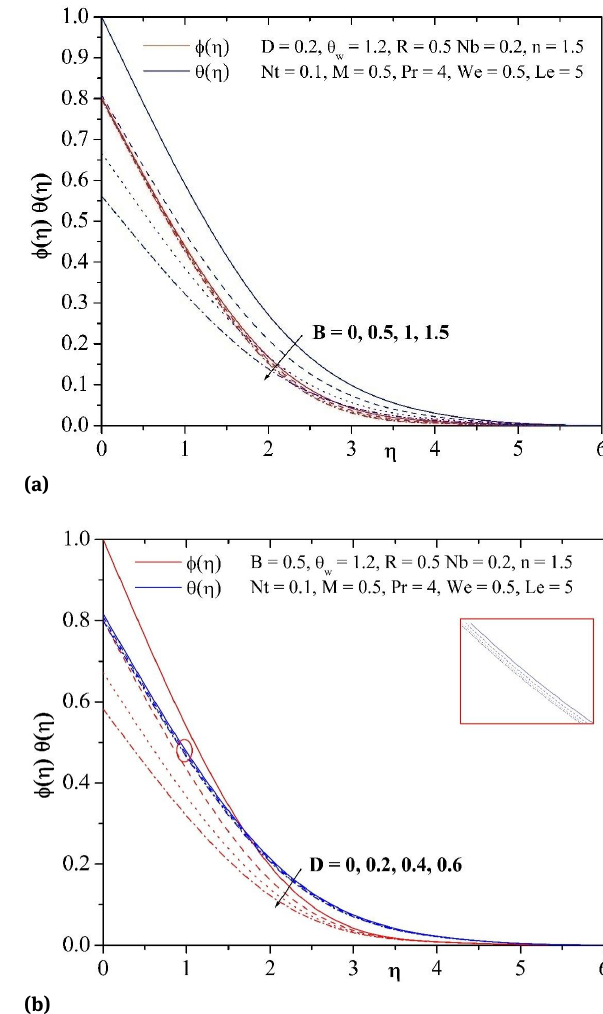
Fig. 4: (a) Influence of M on velocity profile. (b) Influence of M on temperature and concentration profiles.